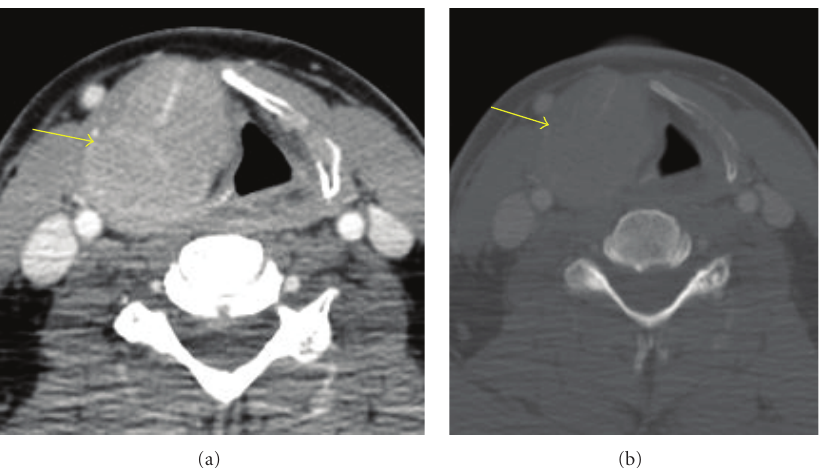
Figure 3: CT, postcontrast, soft tissue (a) and bone windows (b) Uniformly expanded right thyroid cartilage laminae.